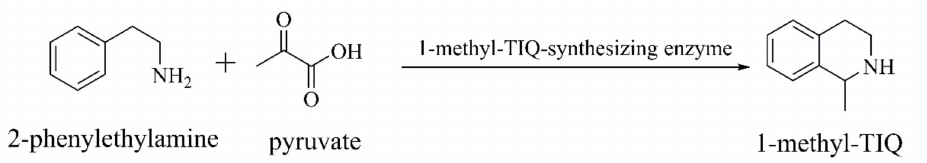
Figure 8. The biosynthesis and metabolism of 1-methyl-TIQ